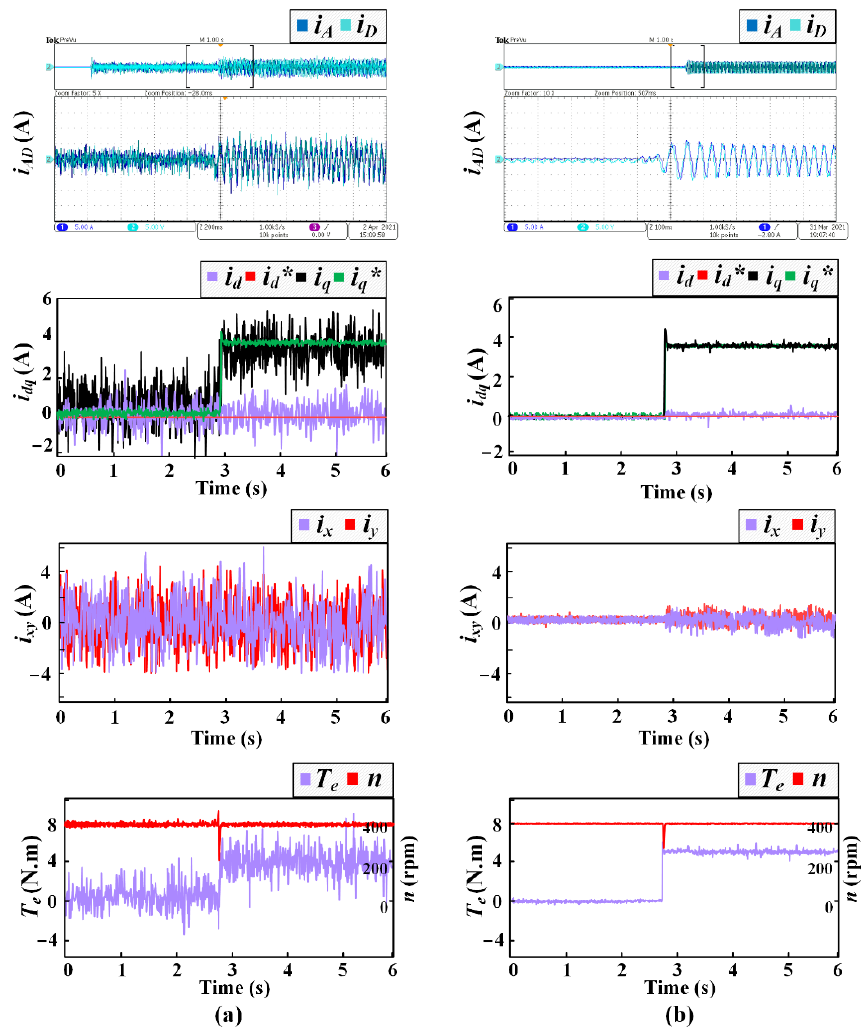
Figure 15. Test 2 for both methods with a sudden load increase. ( a ) Conventional VV-MPC; ( b ) proposed MVV-MPC.